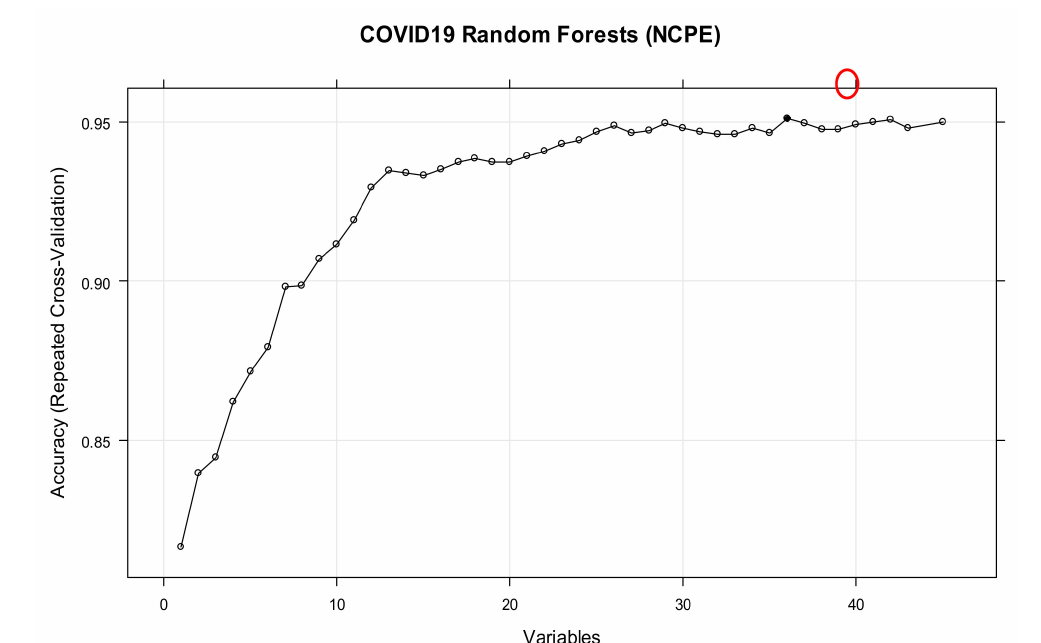
Figure 1. Performance of the RFE based on the ranks of the features of NCPE. The red circle shows the maximum achievable performance based on the best combination of